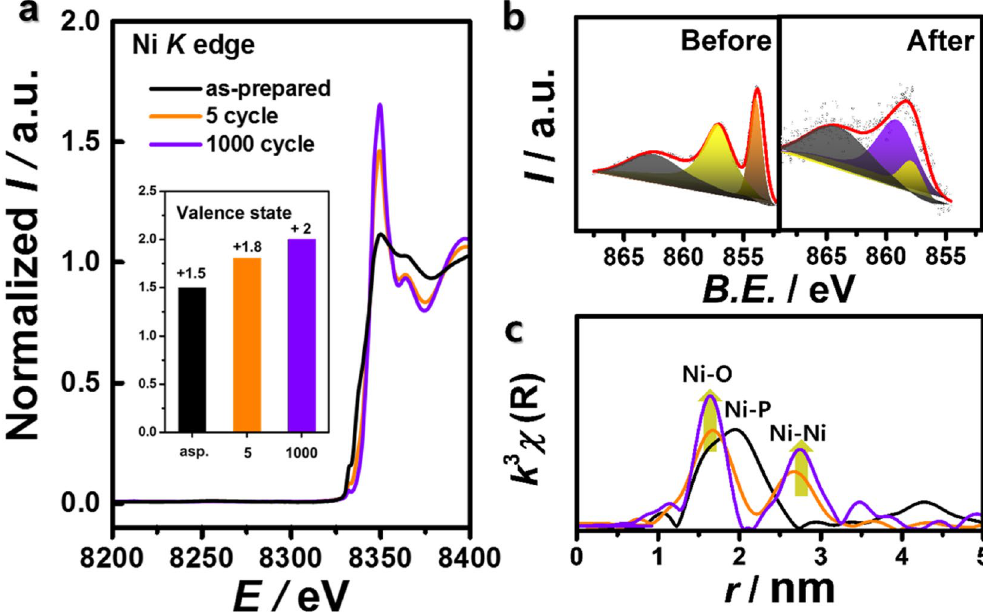
Figure 6. ( a ) X-ray absorption near-edge spectra (XANES) of the Ni K edge ( E 0 = 8333 eV) with a valence states (inset figure), ( b ) X-ray photoelectron spectra (XPS) of the Ni 2 p level before (left) and after the OER (right), and ( c ) extended X-ray absorption fine structure (EXAFS) and structural correlation of Ni 2 P/C after the